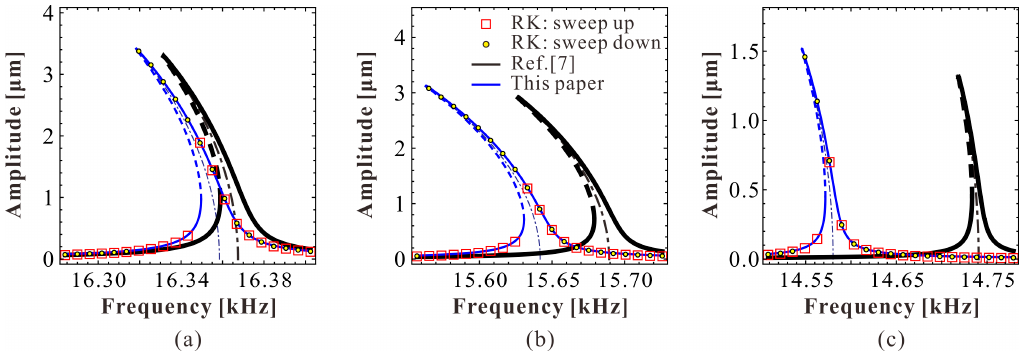
Figure 12. Frequency response curve with low energy corresponding to Figure 9. ( a ) V D = 10 V, V A = 60.46 mV; ( b ) V D = 10 V, V A = 84.62 mV; ( c ) V D = 30 V, V A = 16.11 mV; ( d ) V D = 10 V, V A = 100 mV; ( e ) V D = 24.45 V, V A = 40 mV; ( f ) V D = 30 V, V A = 32 mV. Micromachines 2018 , 9 , x FOR PEER REVIEW